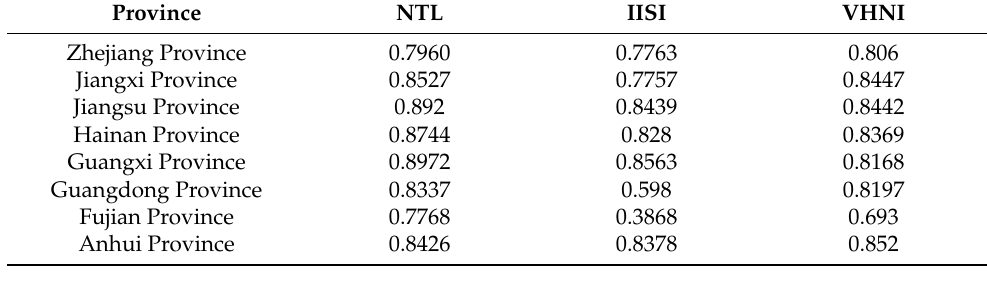
Table 6. Linear regression R 2 between TNL and urban employed population in each province.